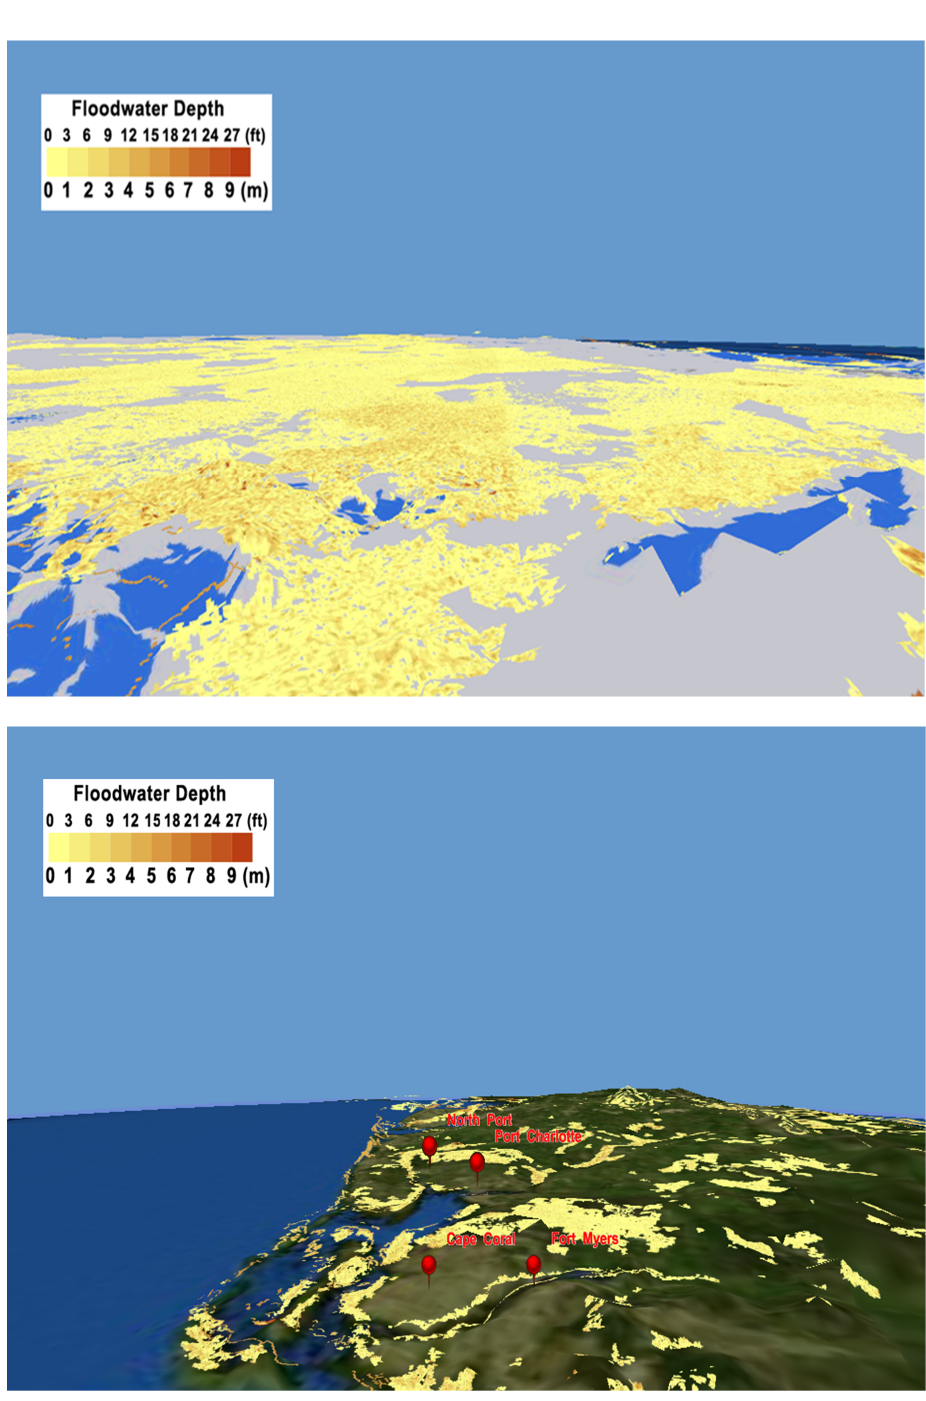
Figure 3. The 3D visualization of the VIIRS downscaled 30 m floodwater depths in southern Florida ( Upper ) and southwest Florida ( Lower ) on 30 September 2022 by using the ArcGlobe.